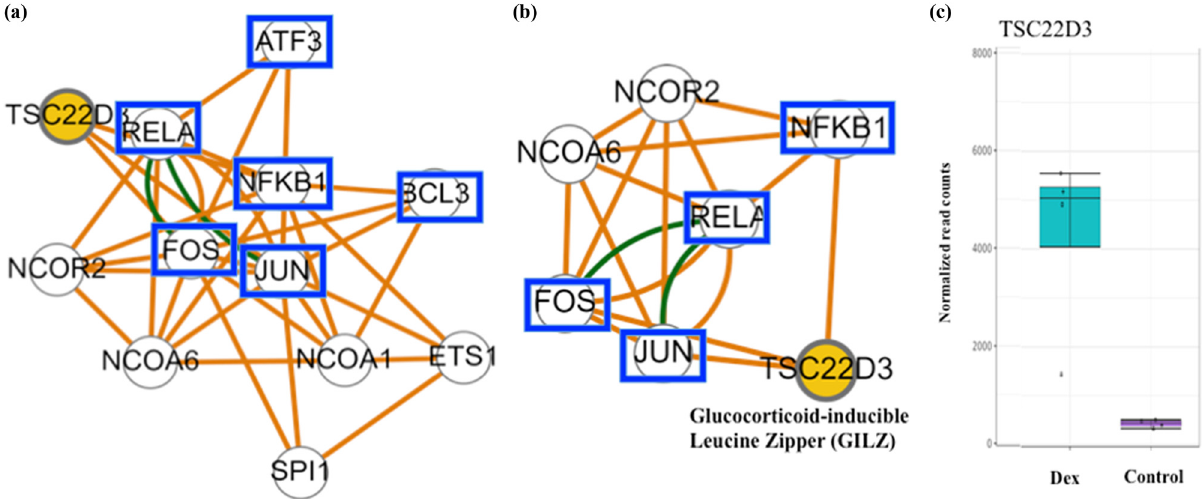
Figure 6: Network analysis of common interaction partners across NFKB and AP1 hubs. ( a ) Signaling pathway across two pairs of hubs ( NF - KB1 vs JUN and FOS vs JUN ) . ( b ) Signaling pathway across three pairs of hubs ( NFKB1 vs JUN, FOS vs RELA, and FOS vs JUN ) . Novel/critical node ( TSC22D or GILT ) is highlighted in yellow color, components of the module are indicated by blue boxes, and genetic interactions by green lines. ( c ) Upregulation of TSC22D3 mRNA expression by DEX in airway smooth muscle cells. Data from eight human donors are retrieved from LCTE. Control and Dex refer to cells untreated or treated with DEX.